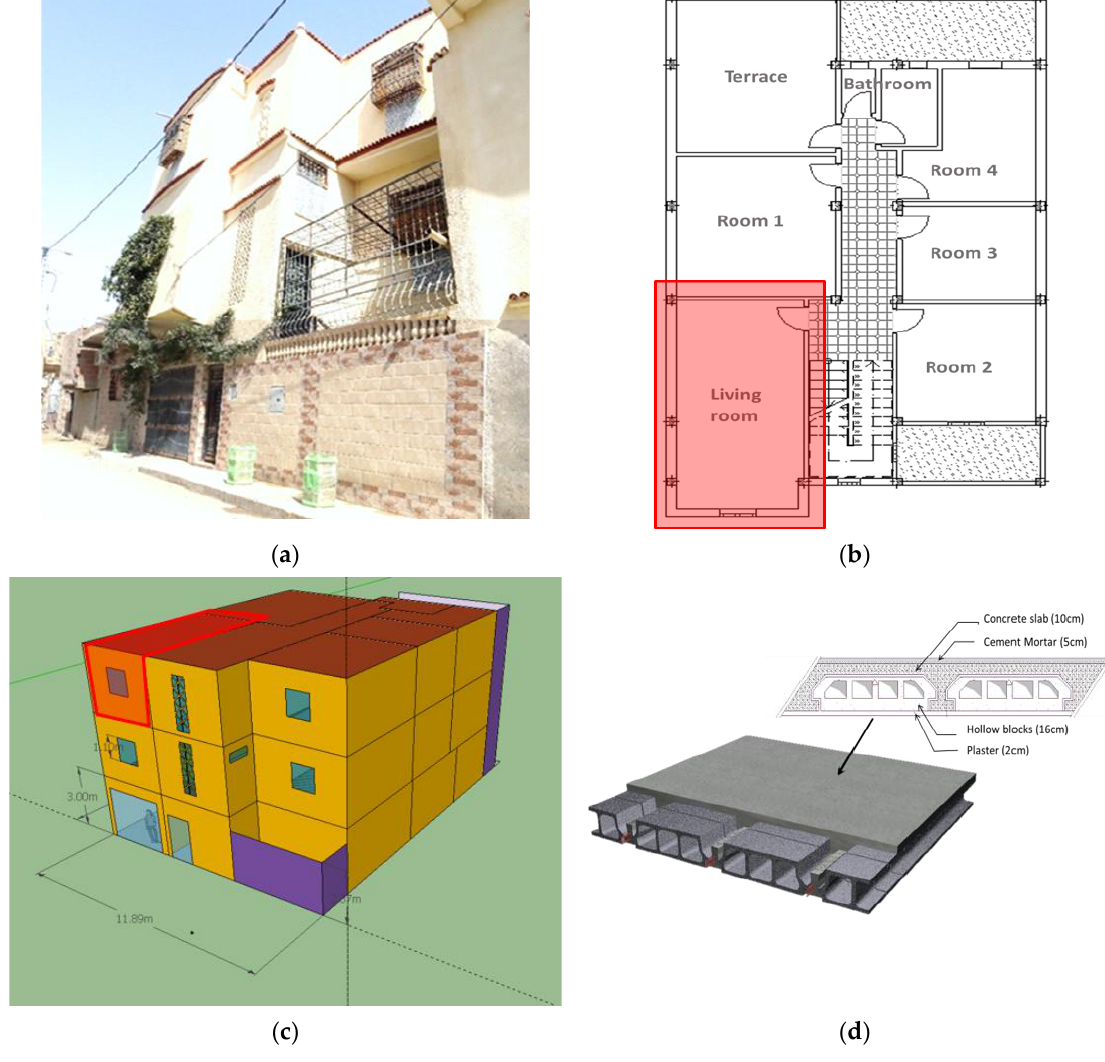
Figure 6. ( a ) View of the single-family house taken as reference case. ( b ) 2nd floor plan showing the living room. ( c ) 3D simulation model. ( d ) Roof construction details.